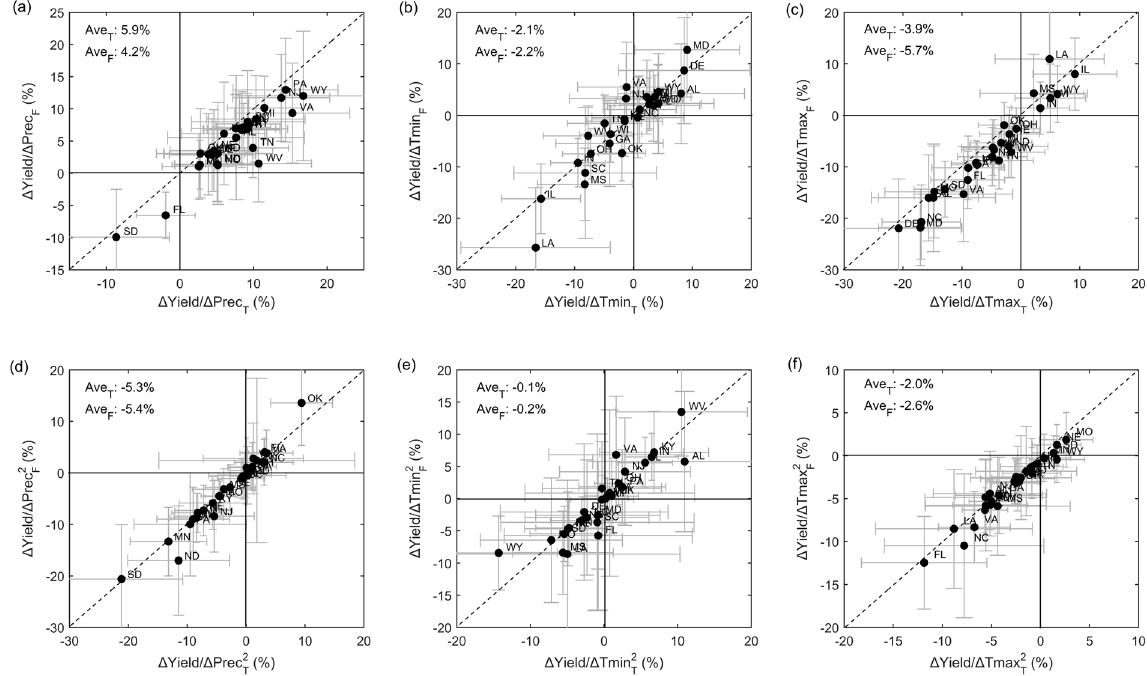
Figure 2. Sensitivity of corn yields to one unit increase of precipitation (Prec), daily minimum temperature (Tmin), and daily minimum temperature (Tmax) estimated by two crop models. The lower case T and F in the x and y labels indicate the estimates based on model with and without considering the changes in crop growing pattern, respectively. The first row is for the corn yield response to linear effects of climate change while the second row is for the non-linear climate effects. The sensitivity is defined as the percentage changes (%) of corn yield normalized by the long-term mean to each 1 mm/day increase of Prec, 1 °C increase of Tmin and Tmax, respectively. The number indicate the average sensitivity averaged over investigated states with weights based on the long-term mean growing area. The error bar denote the standard deviation among the 1000 samples constructed by boot-strap technique to show the crop model uncertainty ranges. Figure was created using software MATLAB 2015a